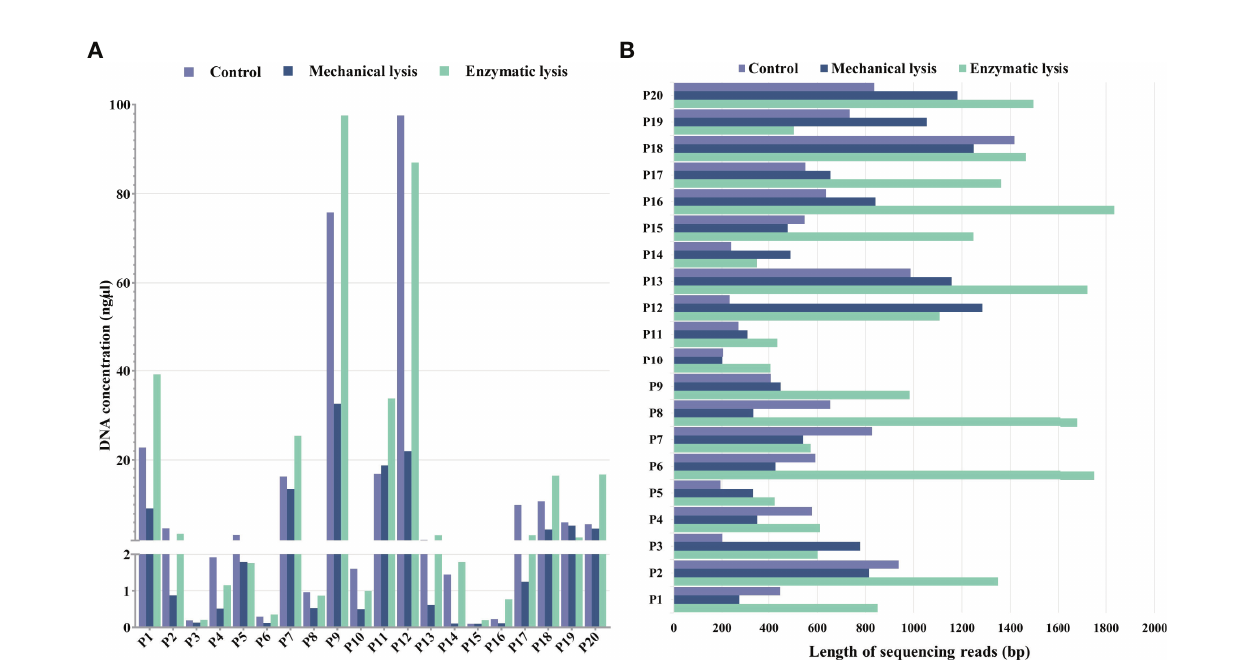
FIGURE 2 | DNA yield and integrity extracted using mechanical lysis and enzymatic lysis. (A) DNA concentrations extracted by three different methods. (B) The absolute average length of microbial sequencing